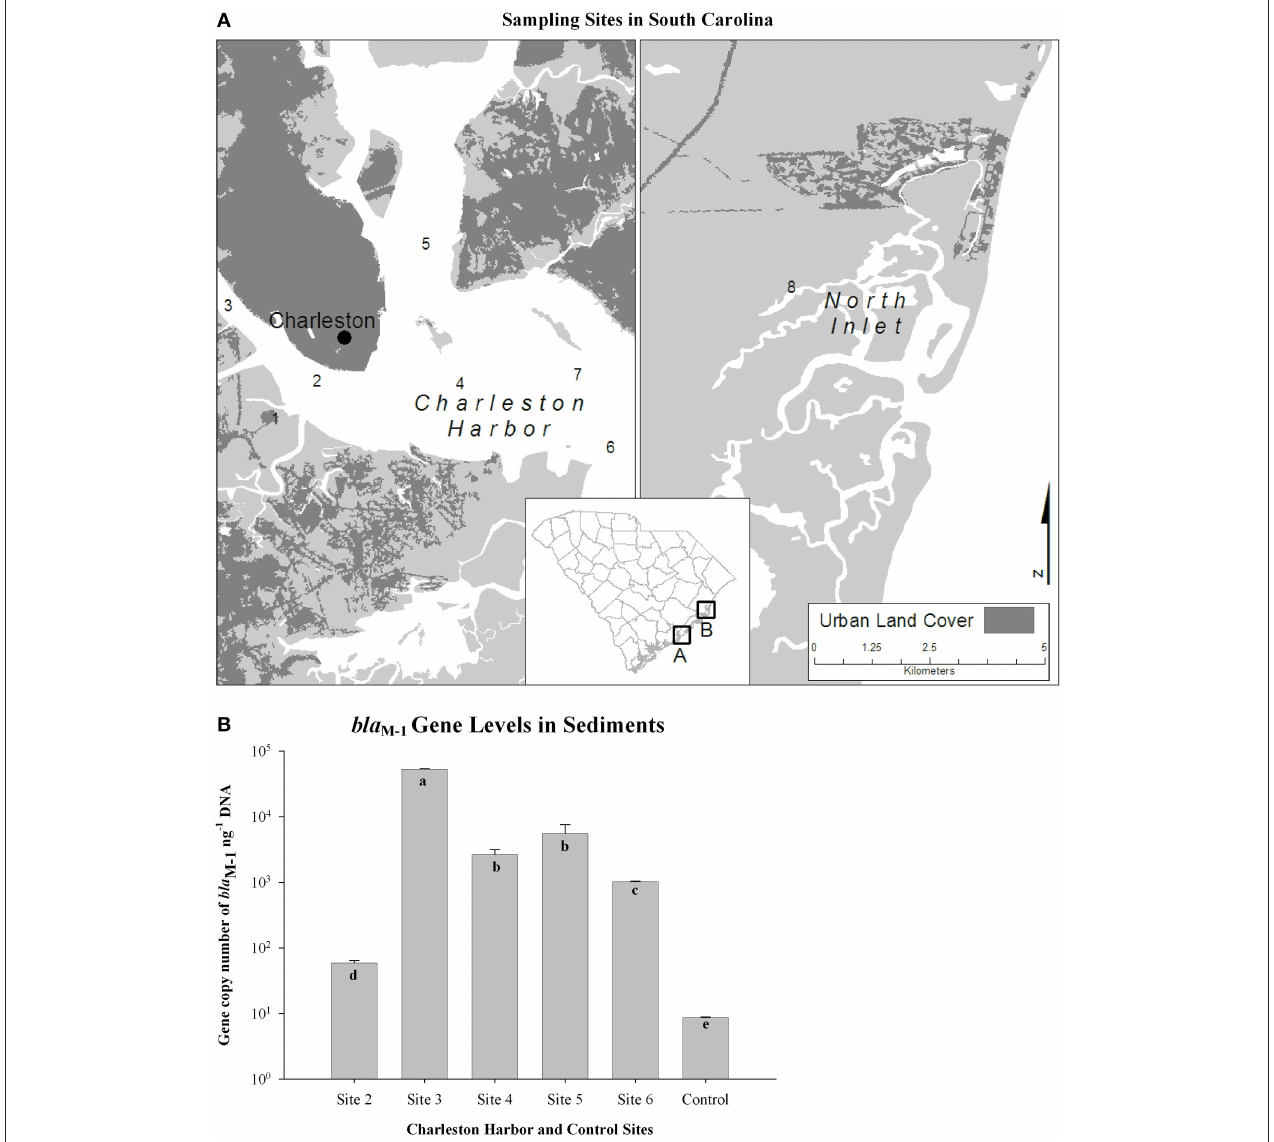
FIGURE 4 | The bla M − 1 gene levels in the environment (modified after Uyaguari et al., 2011, Appl. Environ. Microbiol. 77: 8226–8233). (A) Sampling sites in Charleston Harbor and North Inlet, SC. (B) The bla M − 1 gene levels measured in sediments at each site. Means with different letters (a–d) indicate statistical significance at the 0.05